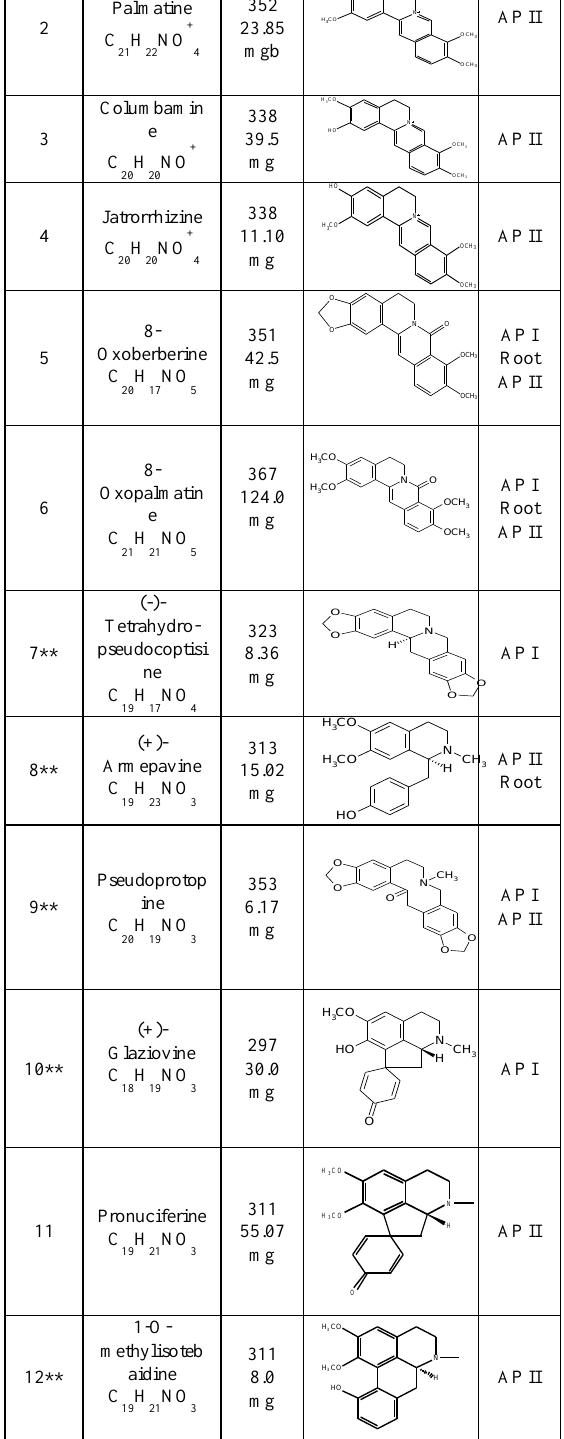
Mole- cular mass, weigh t